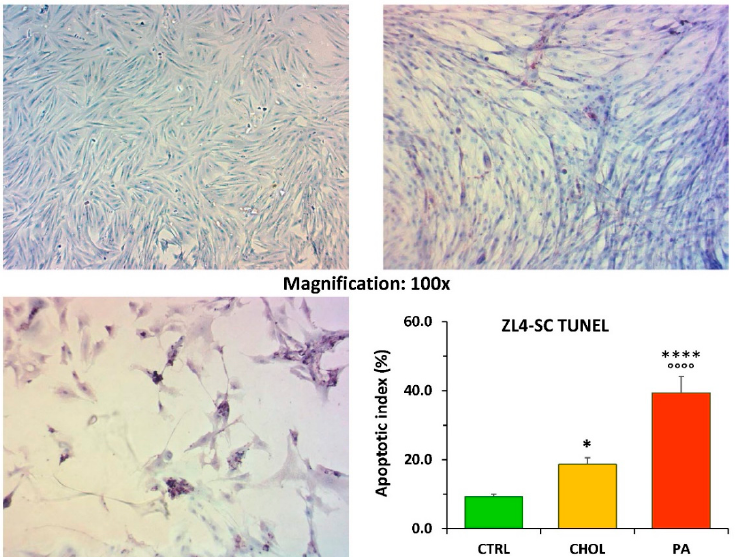
(as saturated free fatty acid) stimulated apoptosis. ZL4-SC were incubated at 10% confluence for 4